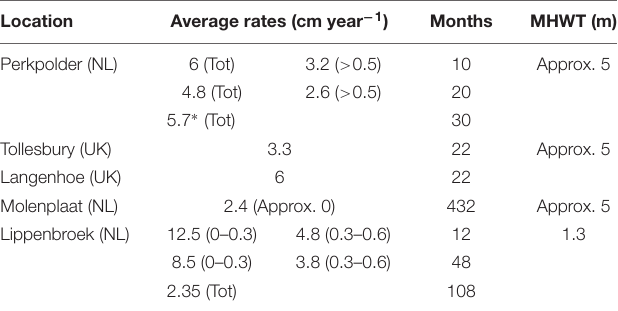
TABLE 2 | Average rates of accretion of different study cases from the Western Scheldt (Netherlands) and South England.